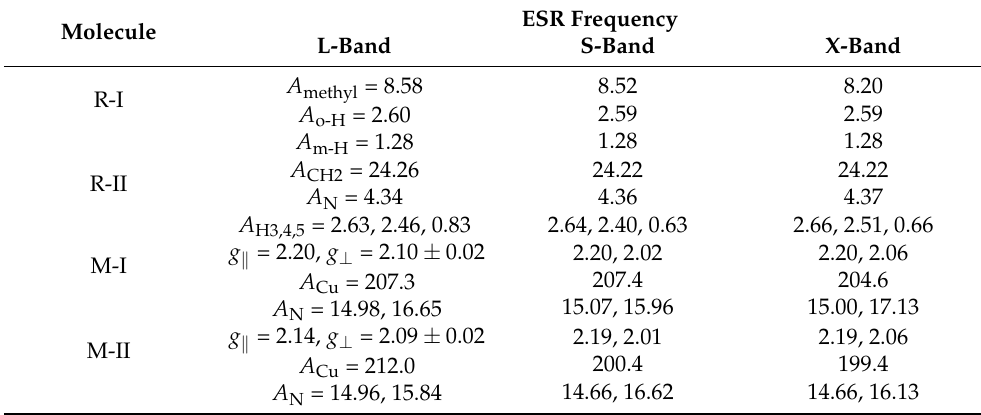
Table 2. Summary of spectral analysis by wavelet